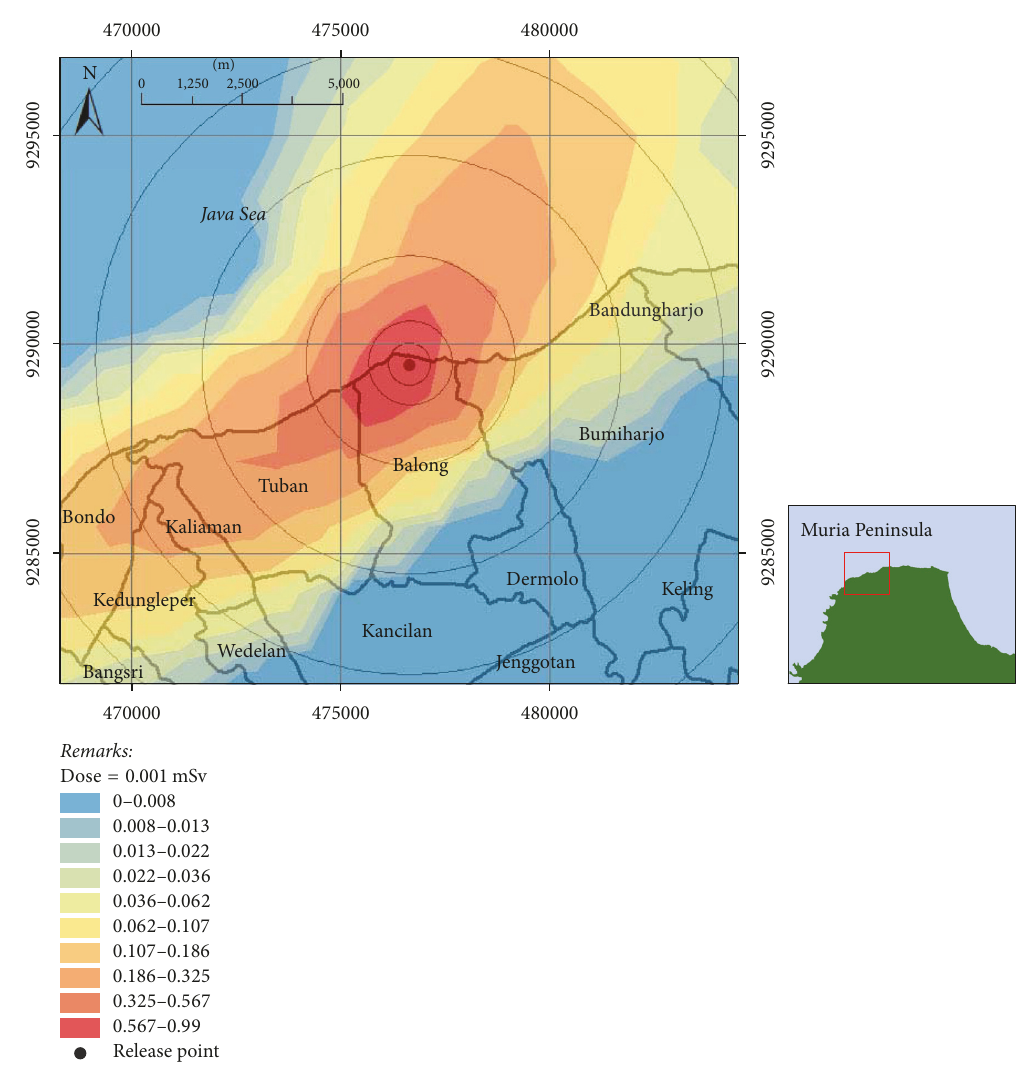
Figure 4: Dose distribution probability ( 𝐷 ≥ 0.001